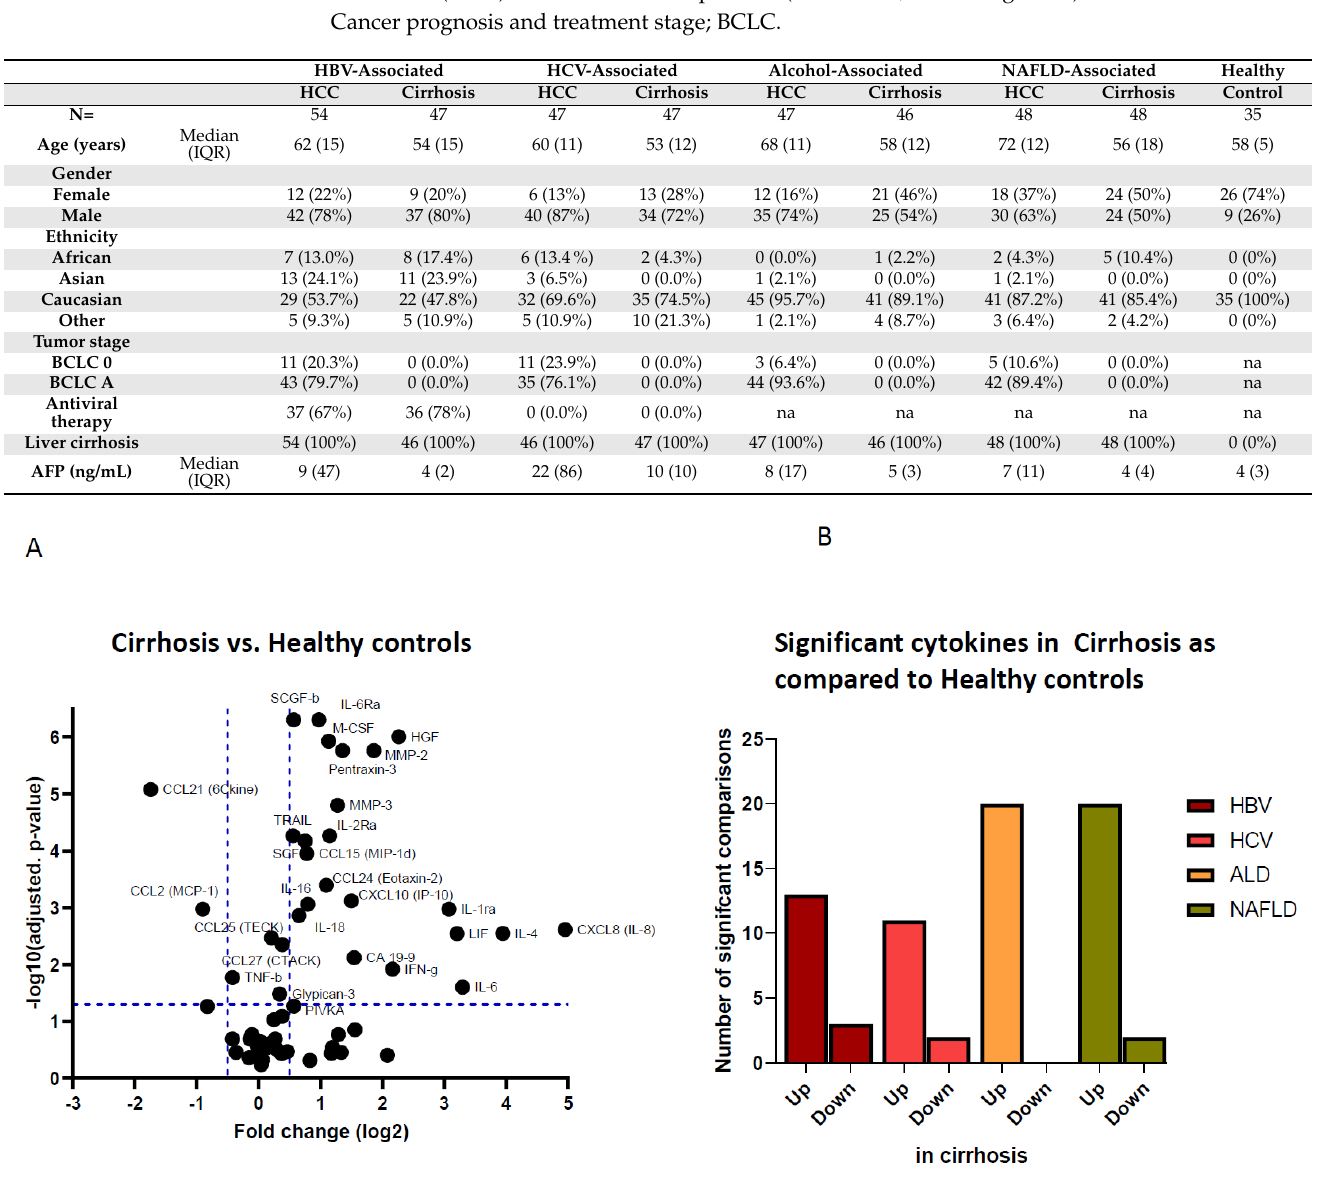
Figure 1. Protein expression of pro-inflammatory and immune regulating cytokines in cirrhosis vs. healthy controls . Vulcano plot of the log2 ratio vs. adjusted p -value of the differential levels of serum cytokines comparing healthy controls (N = 35) vs. liver cirrhosis (N = 188) ( A ). Bar plots show the number of significant Mann – Whitney U tests for the comparison between healthy controls and HBV (N = 47), HCV (N = 47), alcohol (N = 46) and NAFLD (N = 48) compensated liver cirrhosis patients ( B ). ‘Up’ means significant upregulation in cirrhosis and vice versa ‘down’ is significant downregulation in cirrhosis, as compared to healthy controls. All presented p values are adjusted for multiple comparisons using Holm – Bonferroni method.